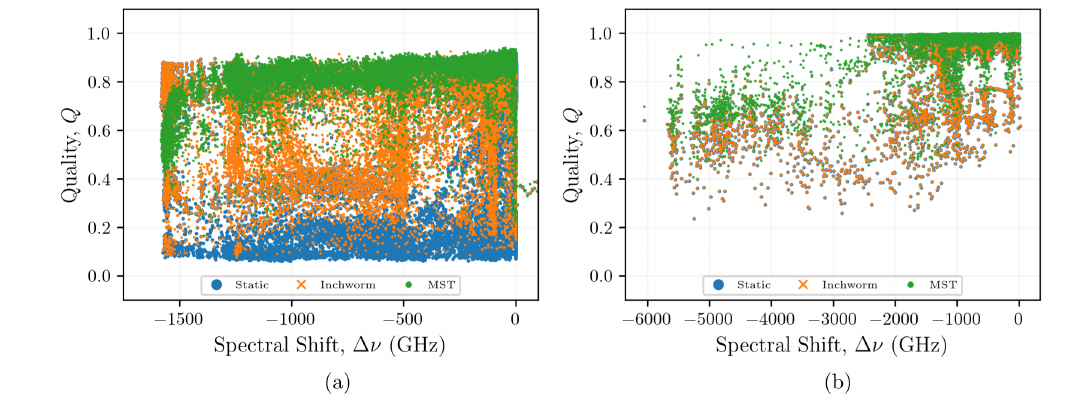
Figure 8. Quality determined using each reconstruction method compared to the spectral shift magnitude determined using the MST algorithm for sensors within the non-grated SMF-28 optical fiber ( a ) and the fiber with Type-II FBGs ( b